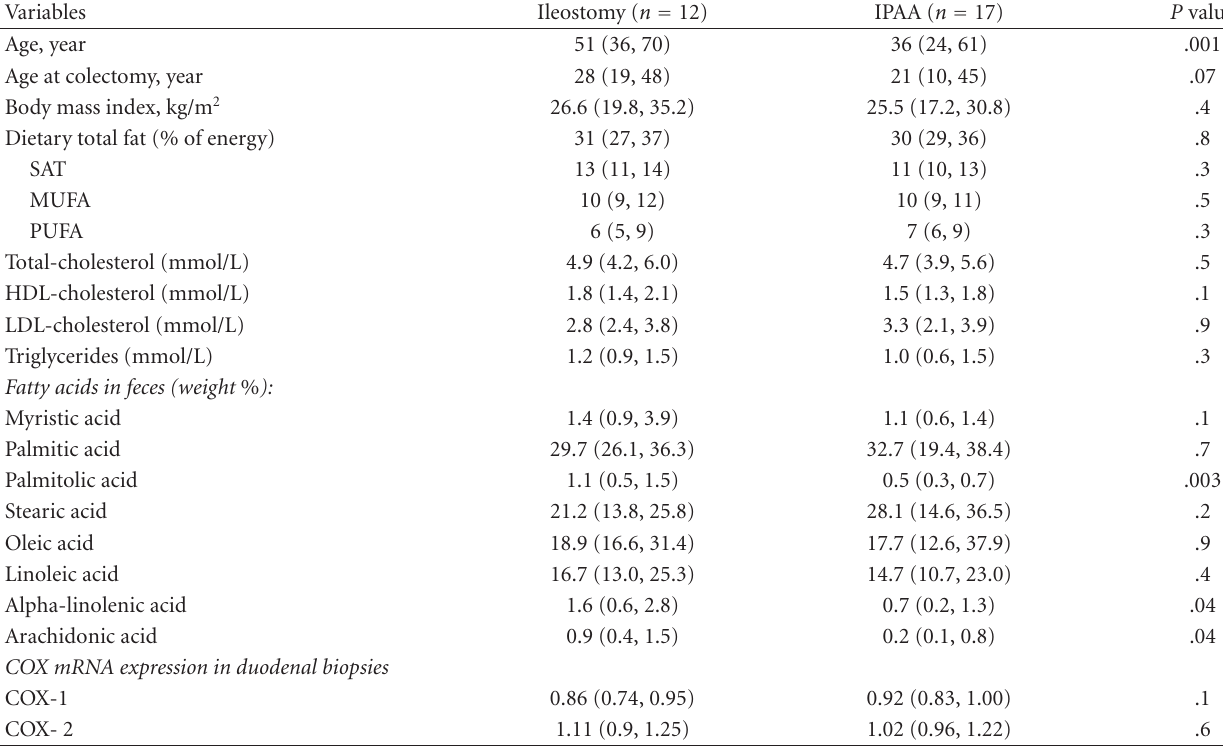
Table 1: Baseline characteristics and fecal composition of fatty acids in colectomized patients with familial adenomatous polyposis. Results are presented as median and 25 and 75 percentiles.